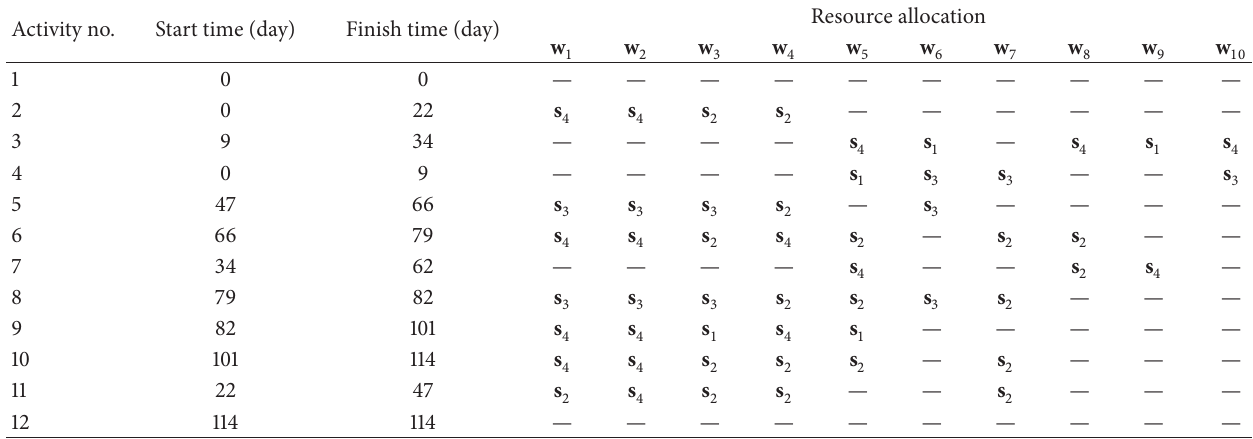
Table 6: Optimal schedule considering no learning